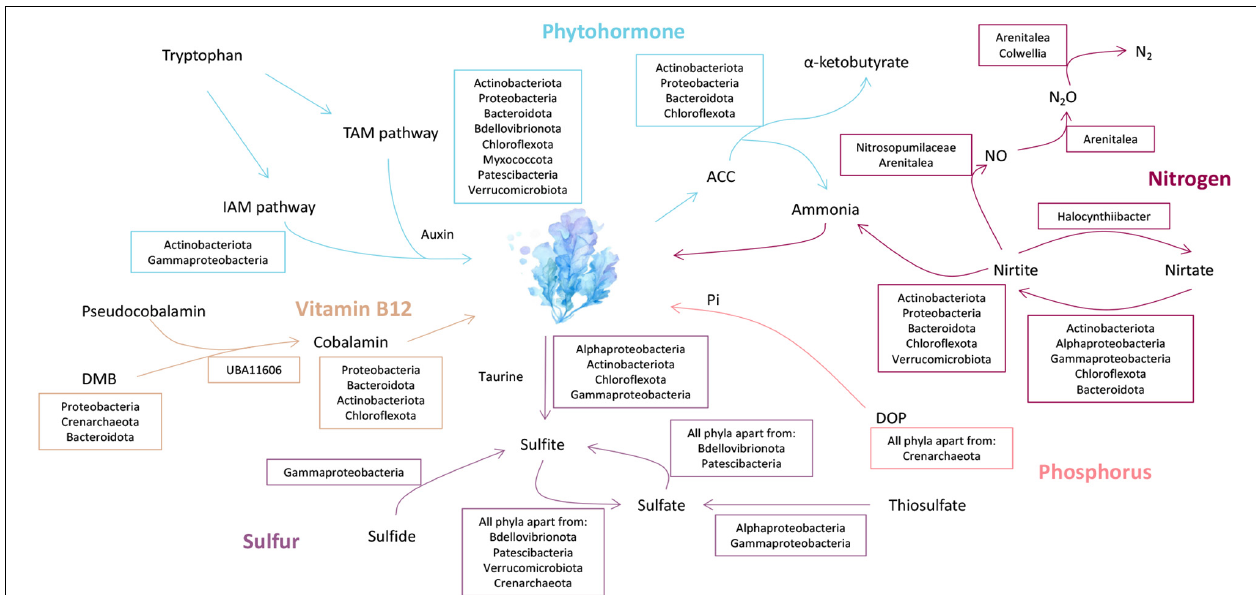
FIGURE 3 | Metabolic reconstruction and the proposed exchange of phytohormone, nitrogen, sulfur, phosphorus, and vitamin B 12 between P. haitanensis symbionts and the host. Blue, phytohormone metabolism; orange, Vitamin B 12 biosynthesis; purple, sulfur metabolism; pink, phosphorus metabolism; and deep red, nitrogen metabolism. TAM pathway, Tryptamine pathway; IAM pathway, Indole-3-acetamide pathway; DMB, 5,6-dimethylbenzimidazole; DOP, dissolved organic phosphorus; ACC, 1-aminocyclopropane-1-carboxylate. Lineages within the taurine metabolism box contain genes encoding for the taurine transporter ( tauACB ) and taurine dioxygenase ( tauD ). The morphology of Pyropia haitanensis is presented in Supplementary Figure 8C